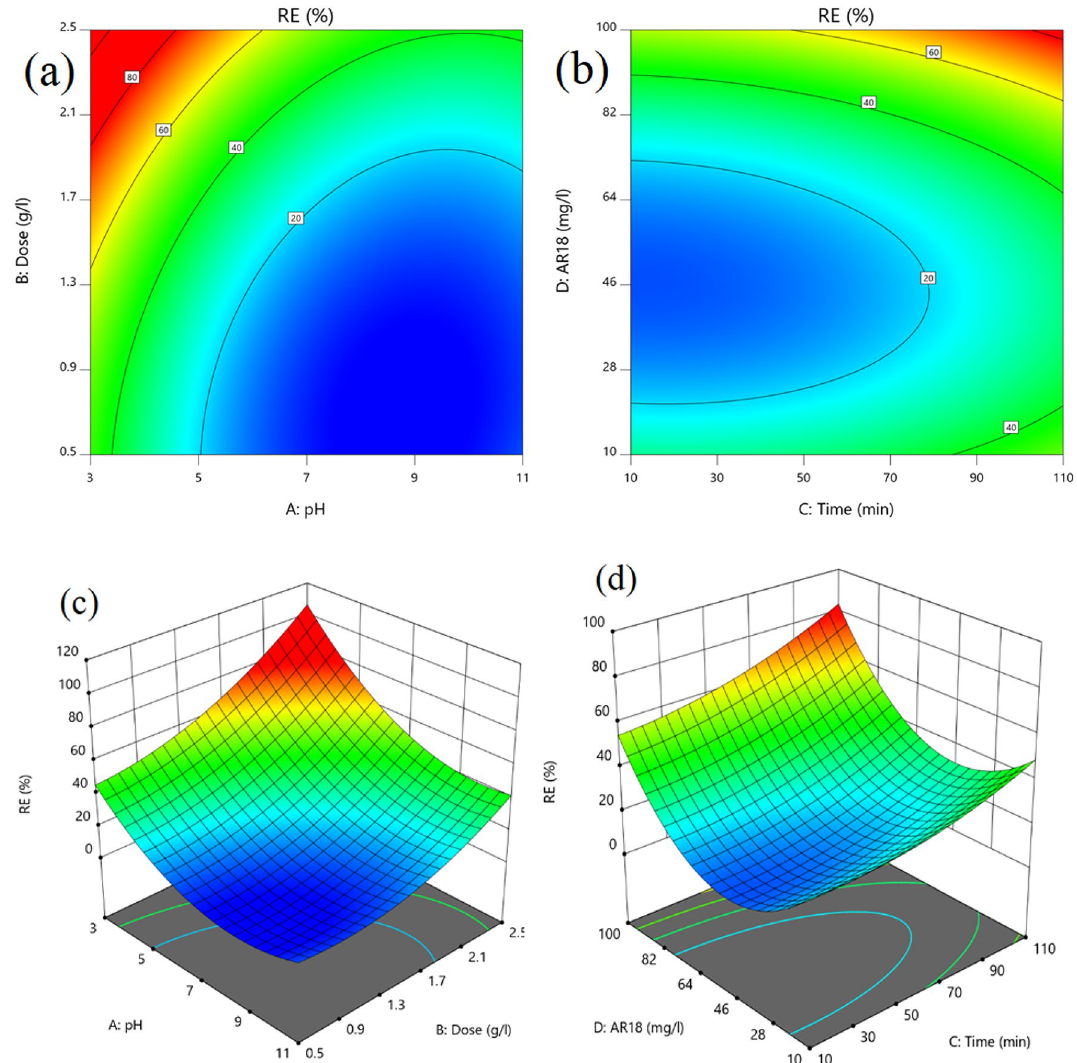
Figure 8. contour plots for effect of pH and adsorbent dose ( a , c ) and initial concentration of AR18 and time ( b , d